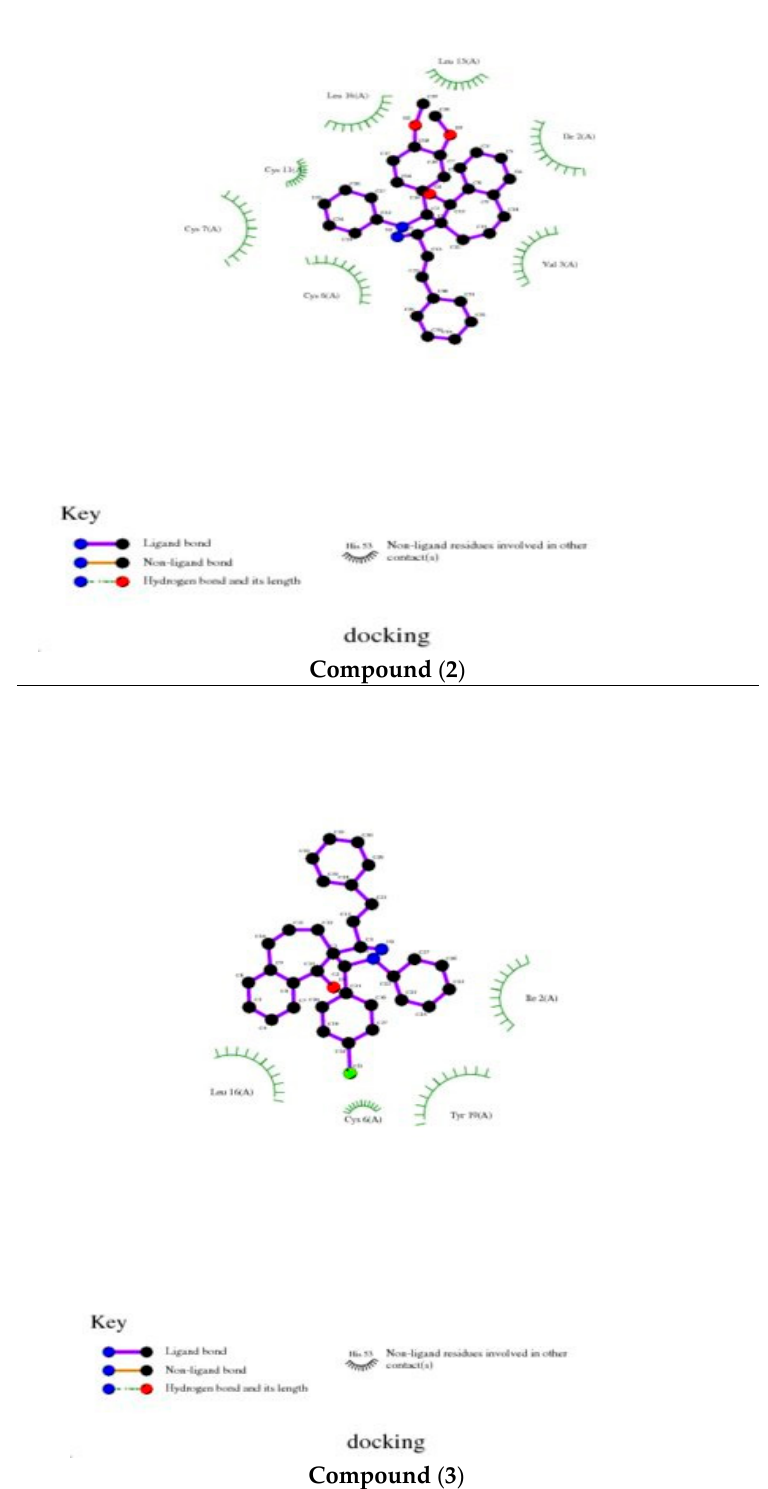
Figure 7. 2D plot of interaction among spiropyrazoles products with 3tt8 receptor.